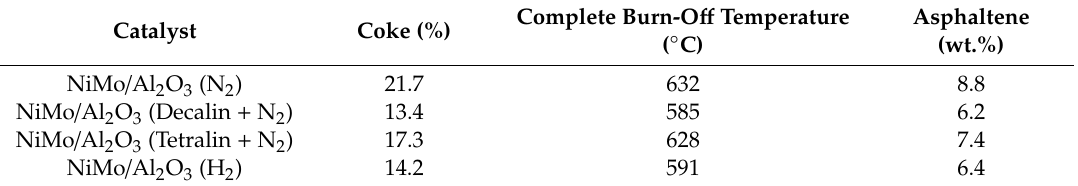
Table 1. Upgraded oil asphaltene content, spent catalyst coke and burn-o ff